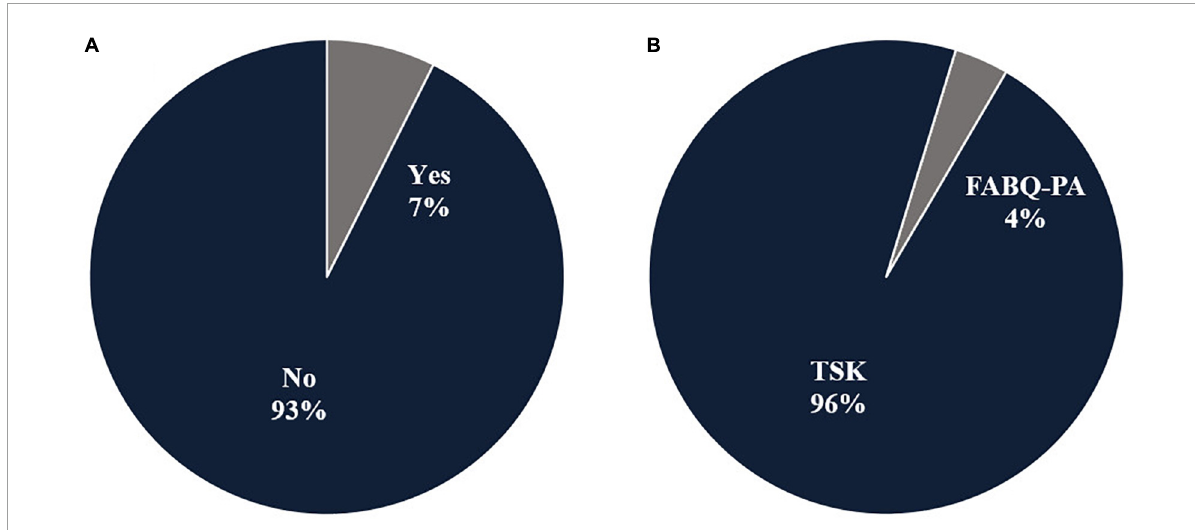
FIGURE4 The relative distribution of included RCTs ( n = 27) according to the following questions. (A) Was kinesiophobia a criterion for participants inclusion? (B) How is kinesiophobia measured? FABQ-PA, Fear avoidance beliefs questionnaire – physical activity scale; TSK, Tampa Scale of